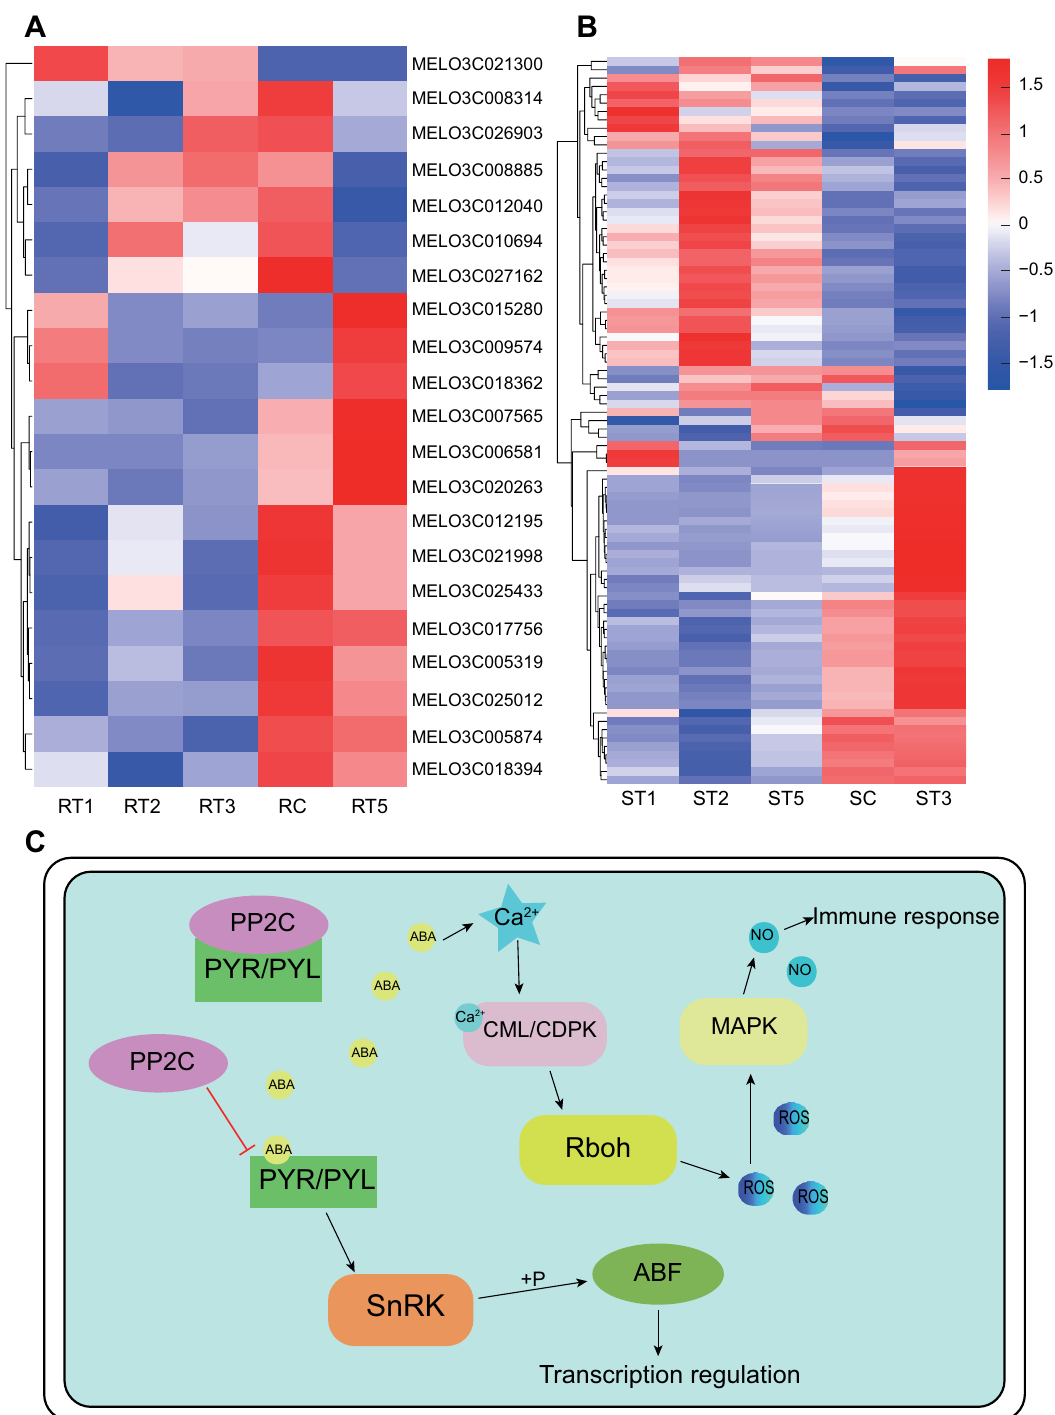
Figure 6. Regulatory pathways of disease resistance and susceptibility genes. Heatmap of expression levels of candidate disease resistance ( A ) and susceptible ( B ) genes post Px inoculation . ( C ) Pathway of disease resistance and